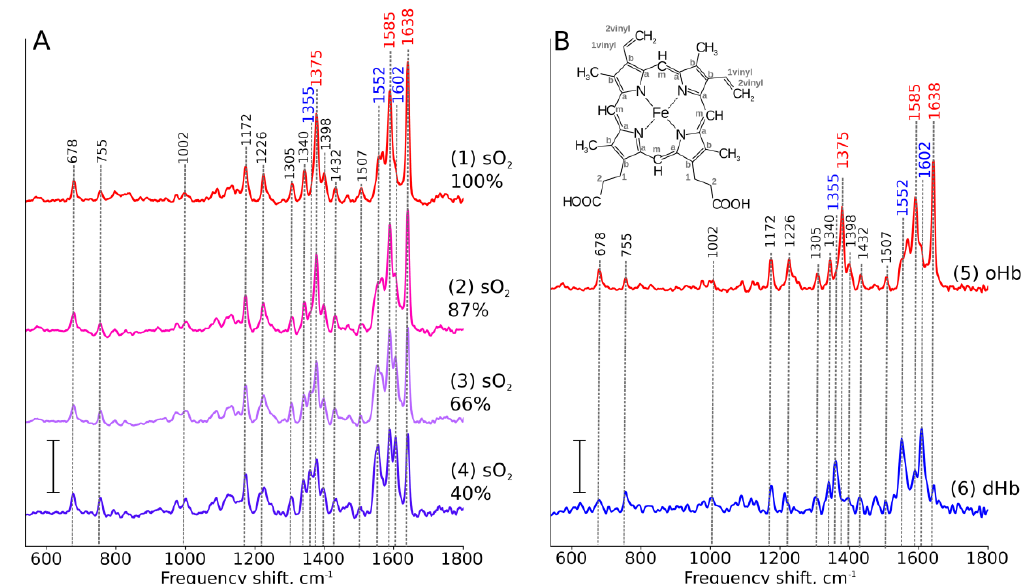
Figure 2. ( A ) Resonance Raman spectra of the blood samples taken from the mouse tail artery under various pO 2 resulting in different oxygenation of hemoglobin (sO 2 ); ( B ) resonance Raman spectra of isolated purified oxyhemoglobin (red spectrum) and deoxyhemoglobin (blue spectrum). Inset figure shows structural formula of b -type heme. Reprinted from [81] with permission of Wiley.